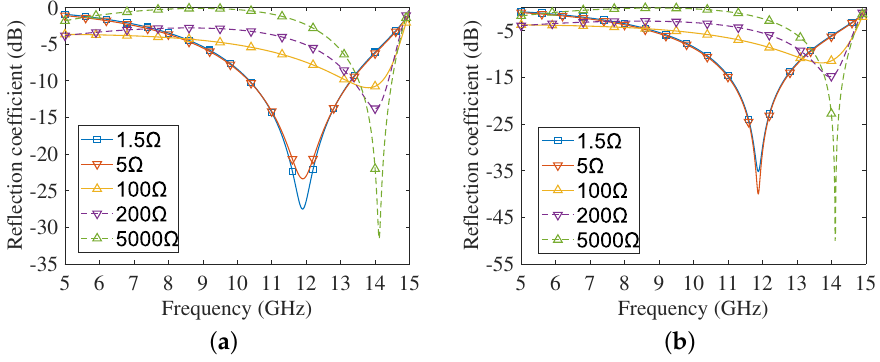
Figure 2. Normal incident reflection coefficient against frequency (5 ∼ 15 GHz). ( a ) Horizontal polarization. ( b ) Vertical polarization.